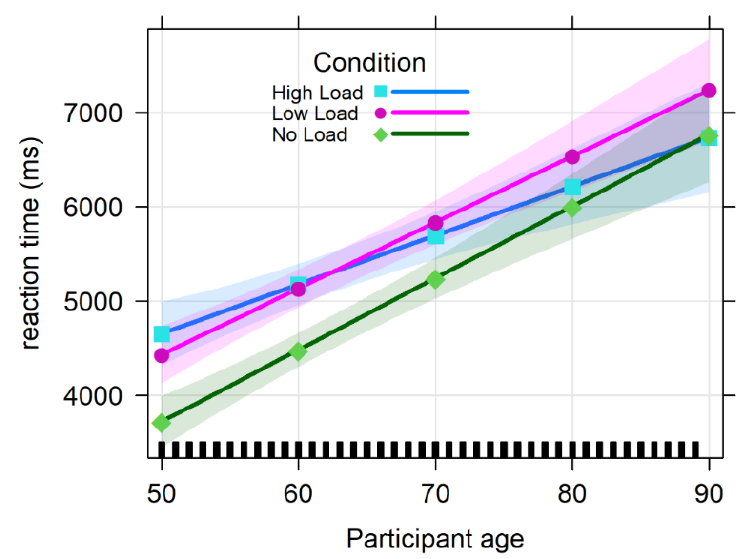
Figure A1. Memory reaction time as a function of Age and Cognitive load (No Load, LL, and HL). Bands represent 95% confidence intervals.